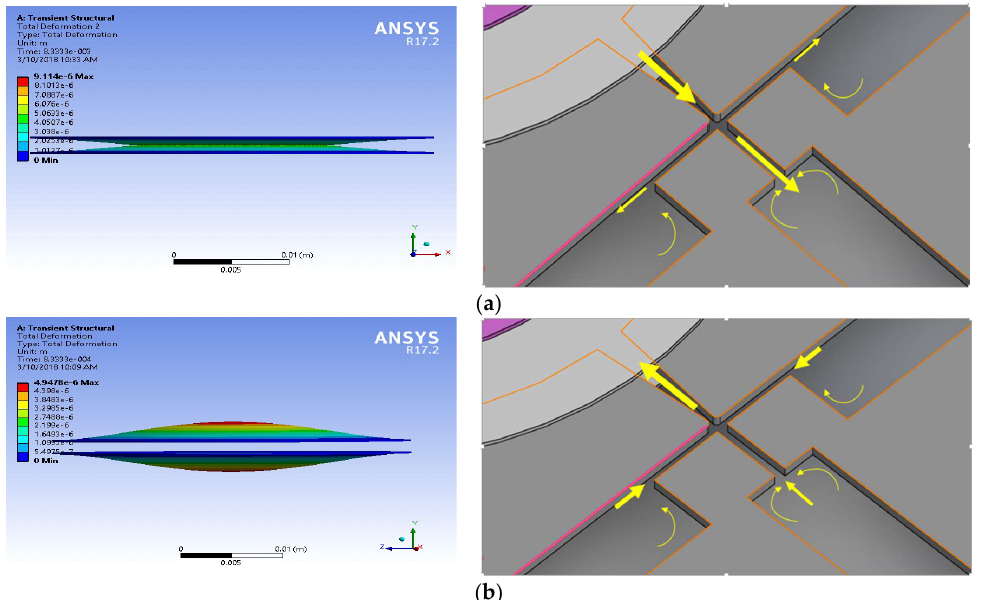
Figure 2. Illustration of working principle: ( a ) Deformation pattern of piezoelectrically actuated (PZT) diaphragm and the fluid flow motion during compression; ( b ) Deformation pattern of PZT diaphragm and the fluid flow motion during suction.